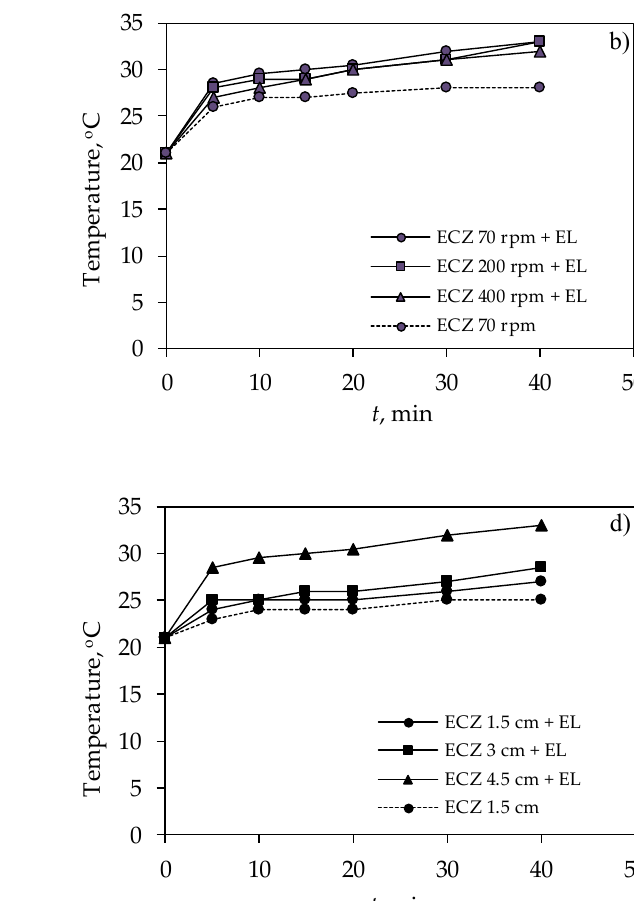
Figure 2. Change of el. conductivity in solution during EC process at different: ( a ) stirring speed; ( b ) stirring speed with the addition of zeolite; ( c ) electrode distance; ( d ) electrode distance with ad- dition of zeolite. Note: mark EL means the addition of electrolyte.